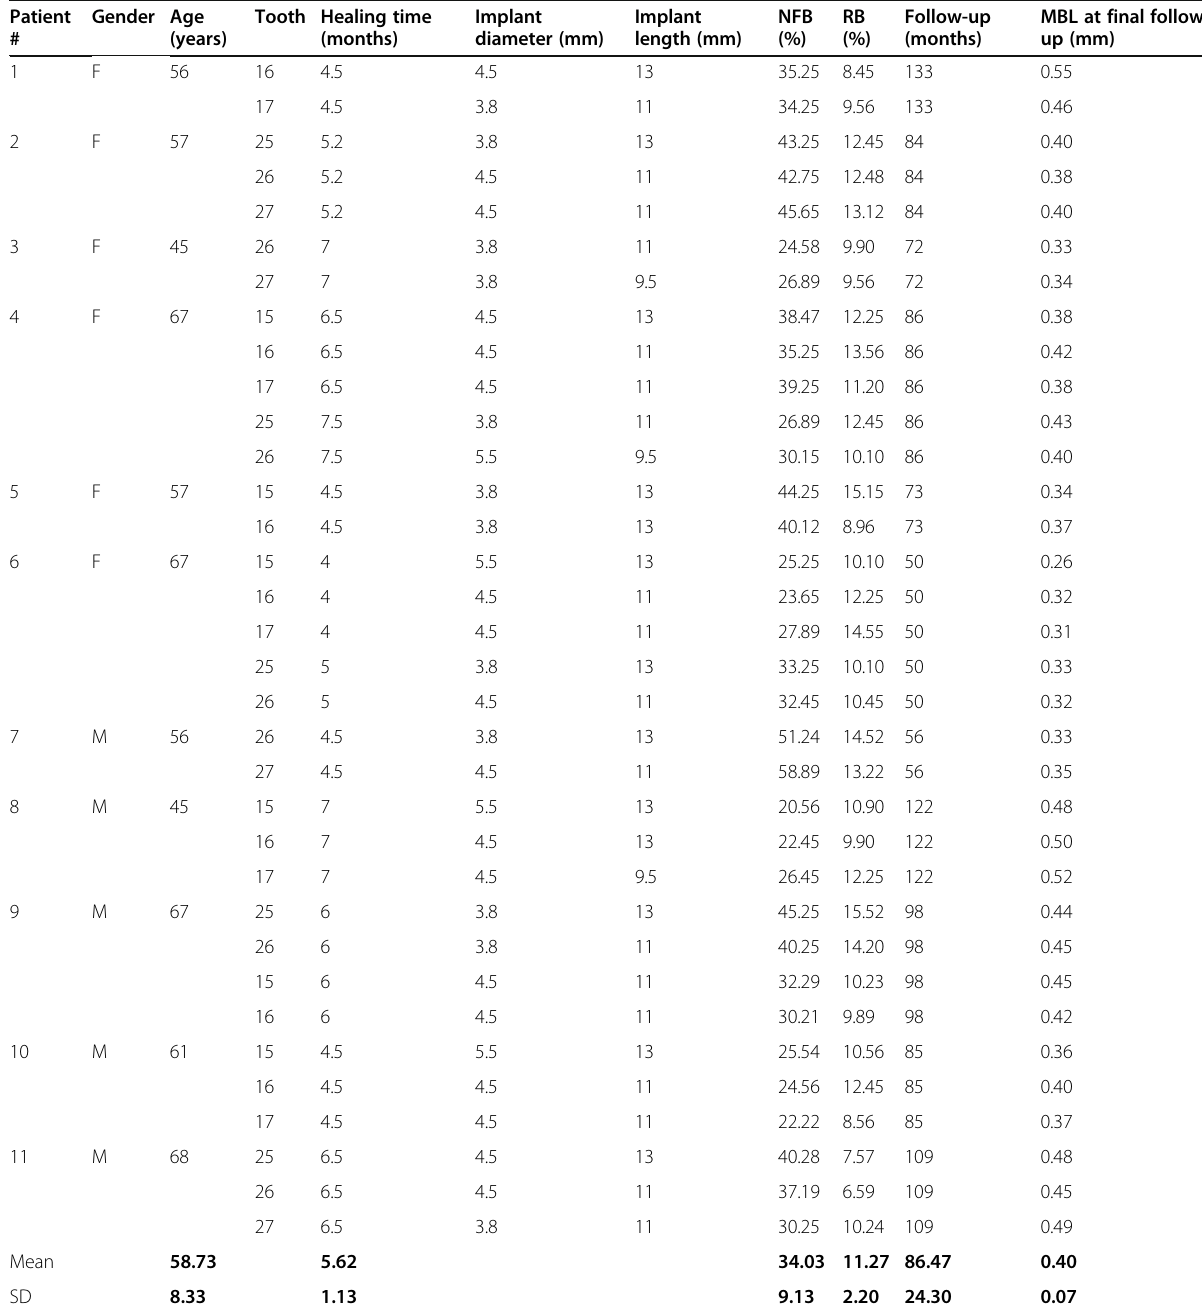
Table 1 The study data. Healing time (months) is the time from grafting surgery to implant placement. Follow up (months) is the time of the last control visit from definitive implant loading Patient